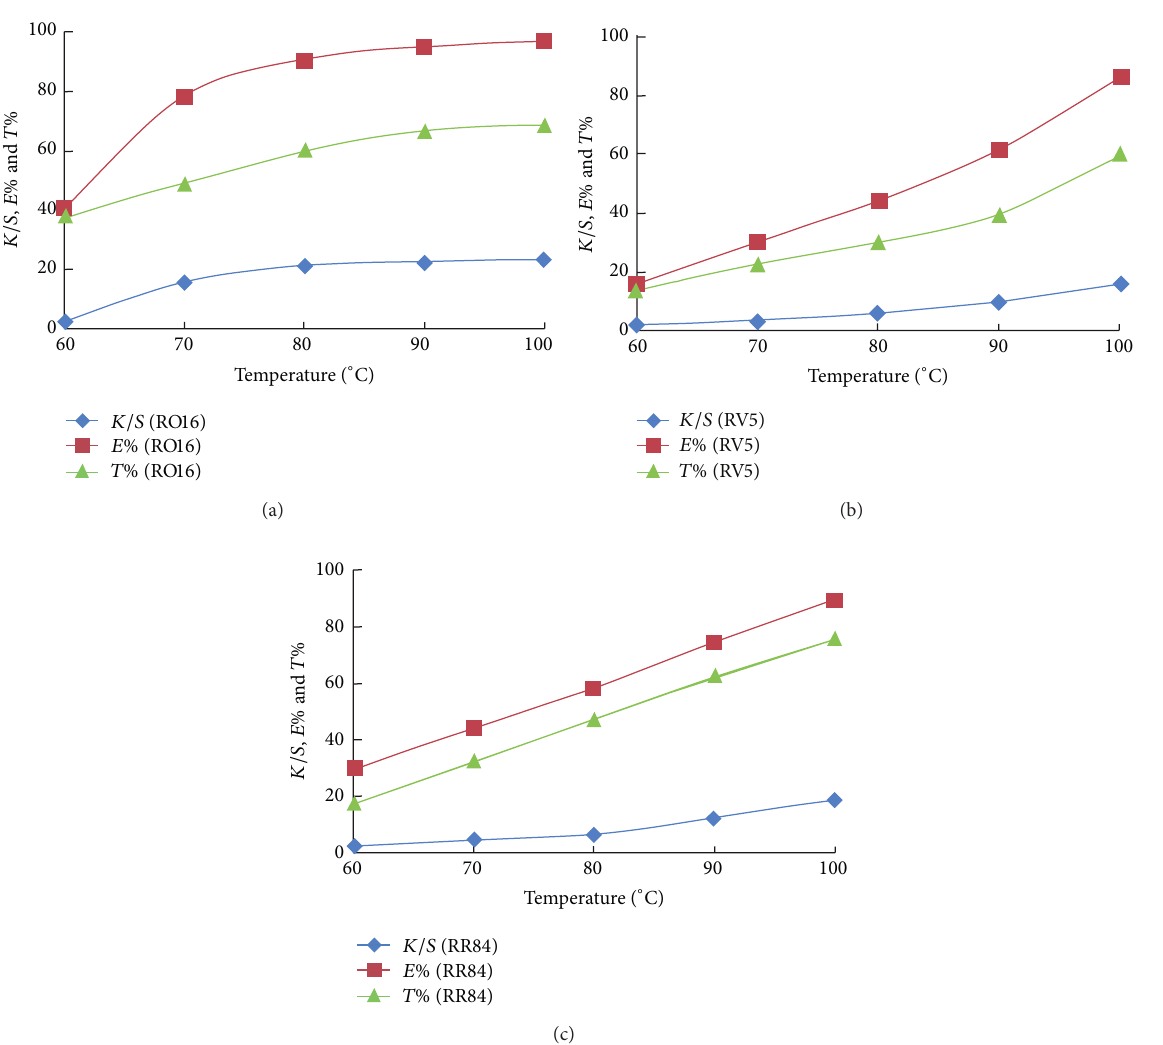
Figure 4: Effect of temperature on the exhaustion, total fixation, and colour strength of CI Reactive Orange 16 (A), CI Reactive Violet 5 (A), and CI Reactive Red 84 (A) on amidoximated acrylic fabrics; dyeing conditions: shade 2% owf, liquor ratio 40 : 1, pH 2.5, for